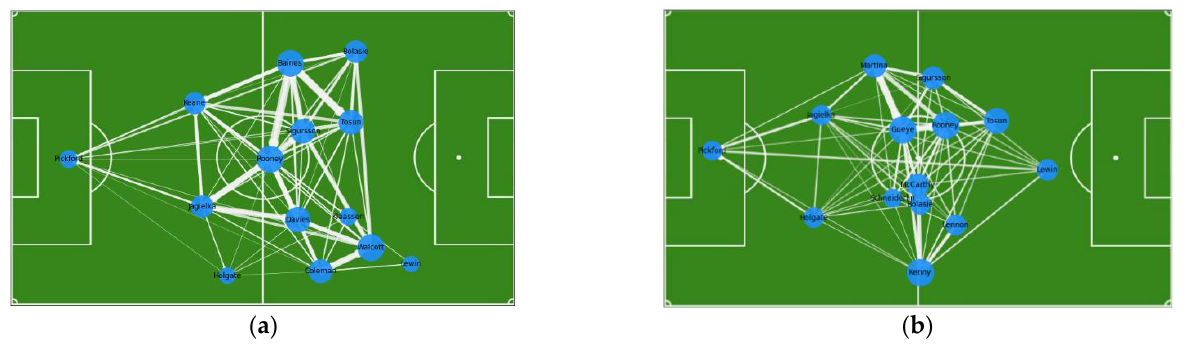
Figure 5. Comparison of Everton’s passing network in typical matches .